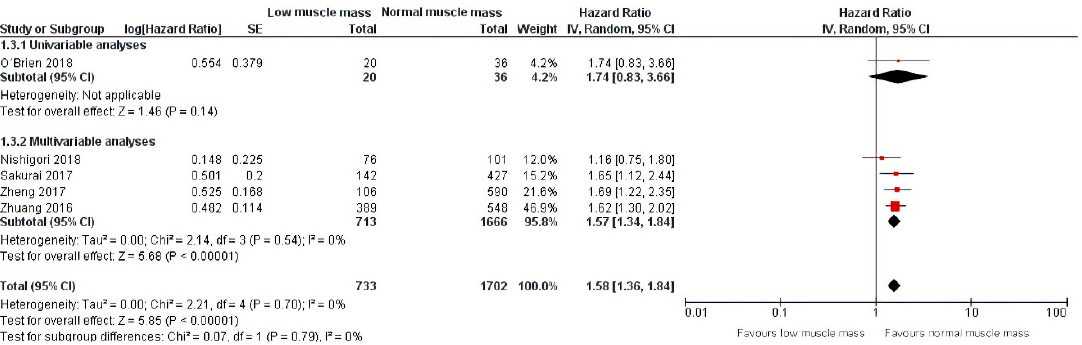
cancer patients with low muscle mass versus normal muscle mass.